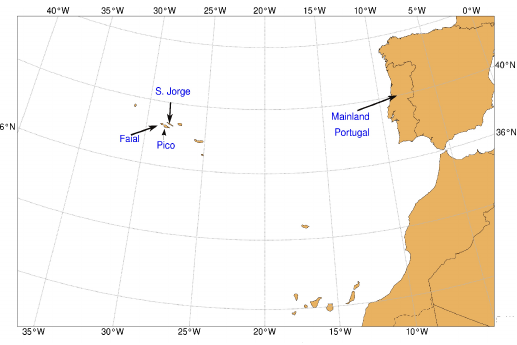
Figure 1. Macroscopic view of Pico Island’s location relative to Mainland Portugal.